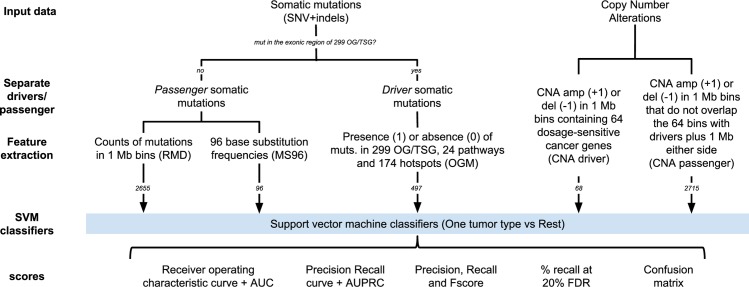
Schematic overview of the analyses.